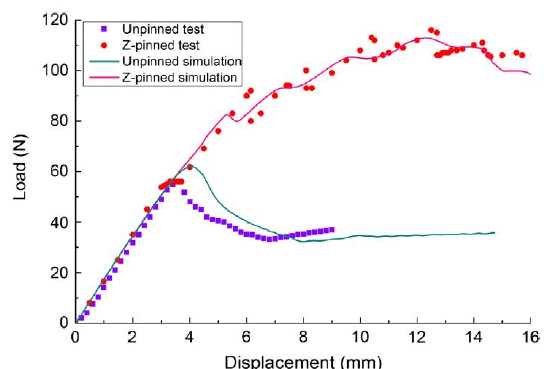
Figure 66. Force–displacement curves for cohesive model compared with experiment (G II / G Total = 20%, CFRP z-Pins) [30].